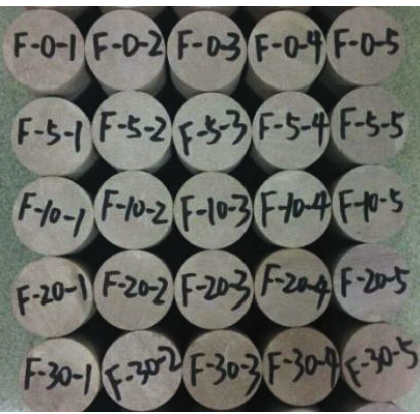
Figure 1: Grouping and numbering of sandstone